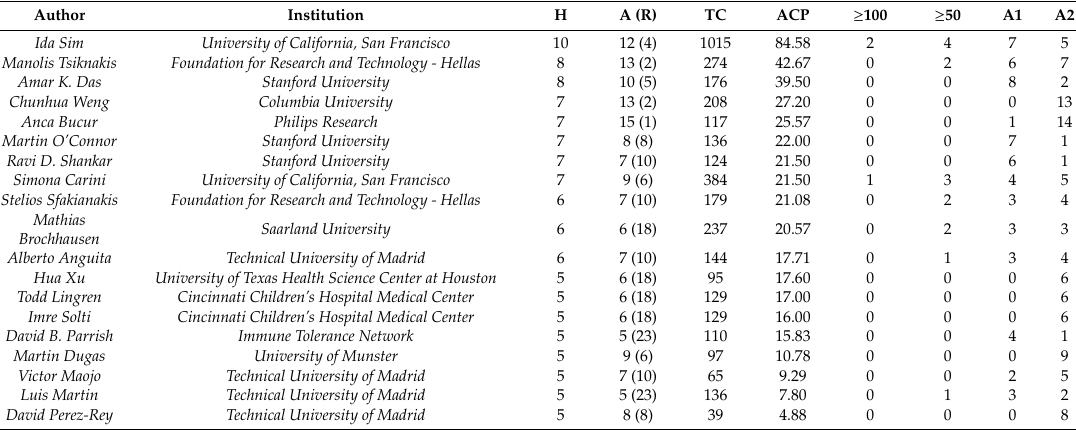
Table 8. Distribution of articles by